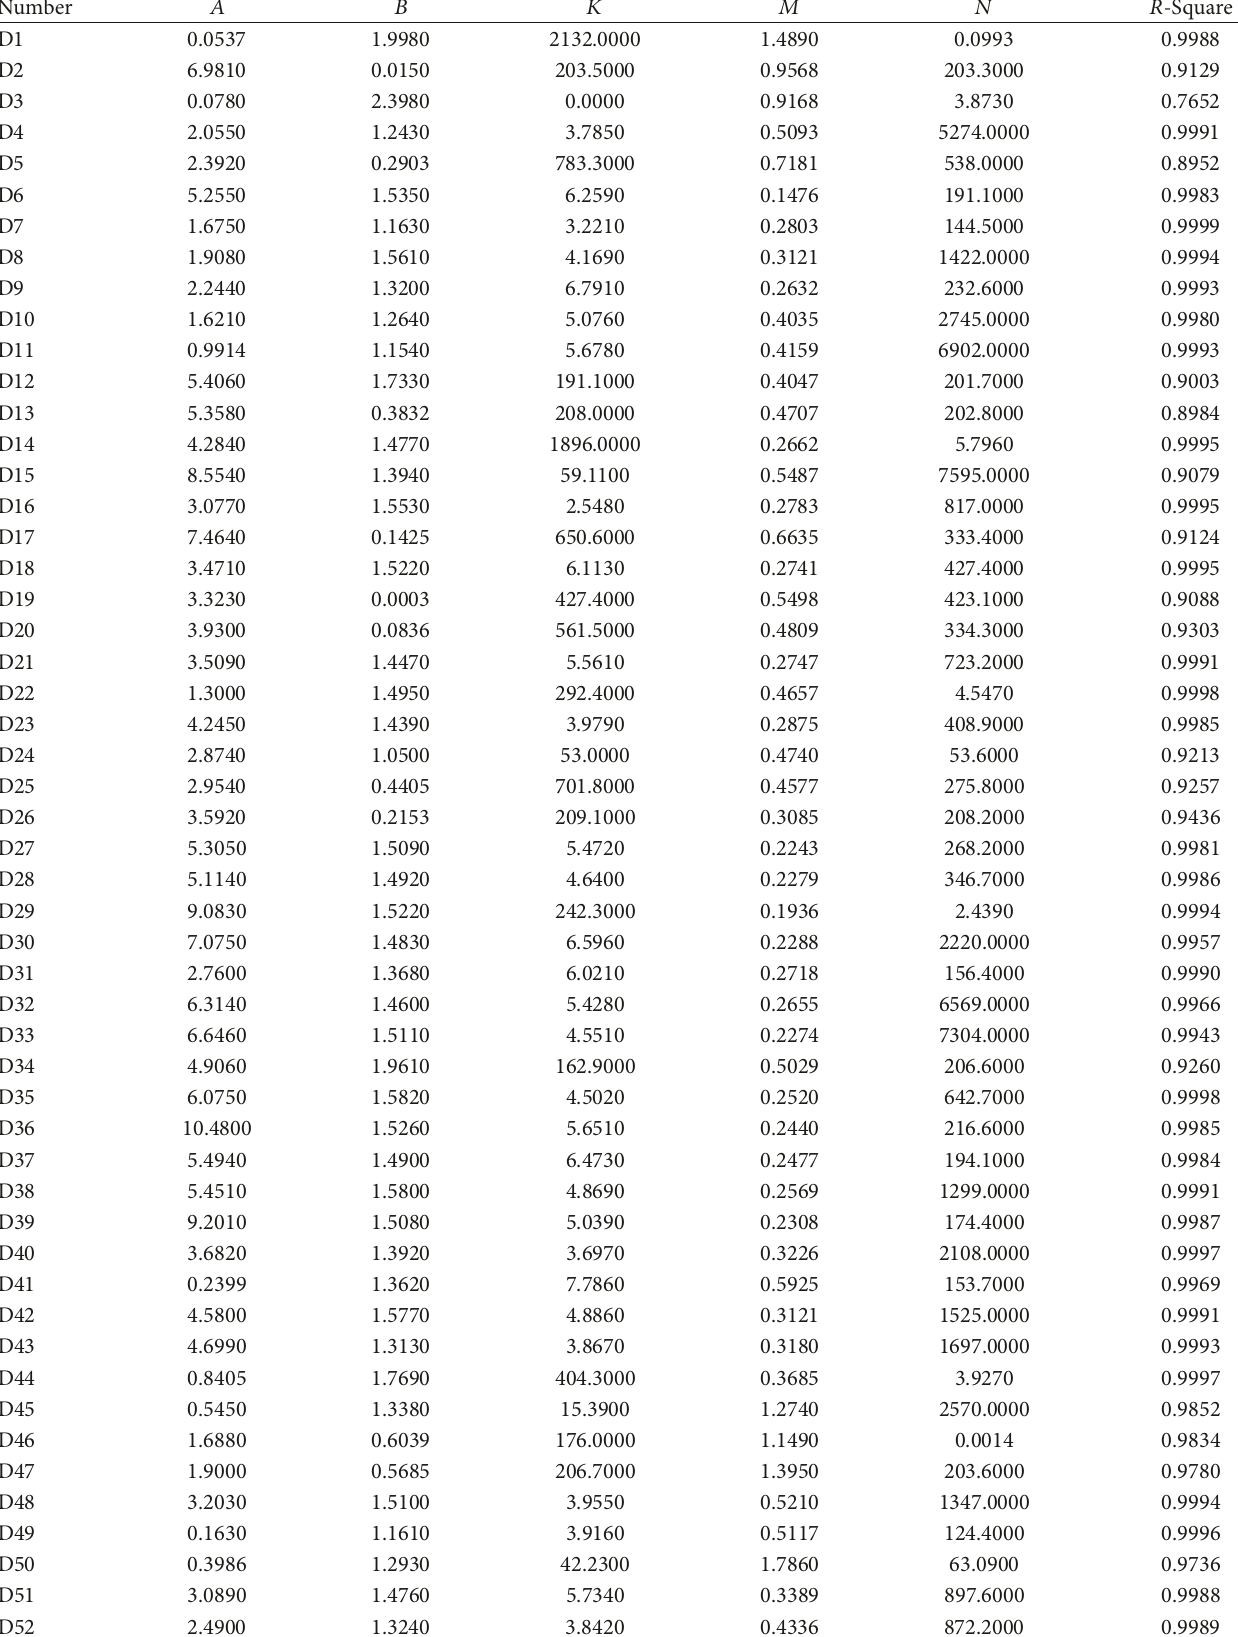
Table 1: Curve fitting parameters of shale adsorption isotherm for 80